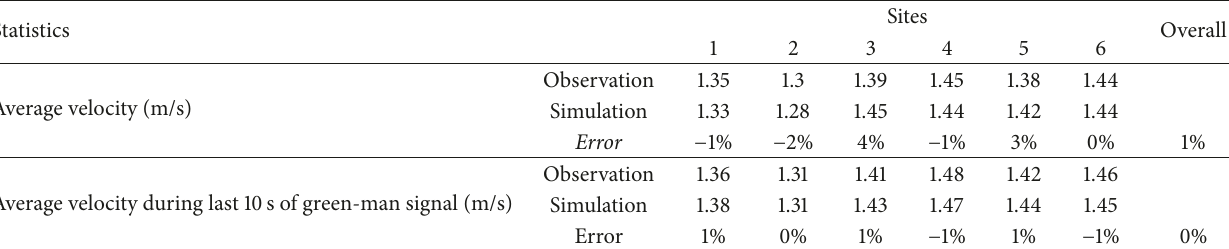
Table 6: Validation of proposed CA